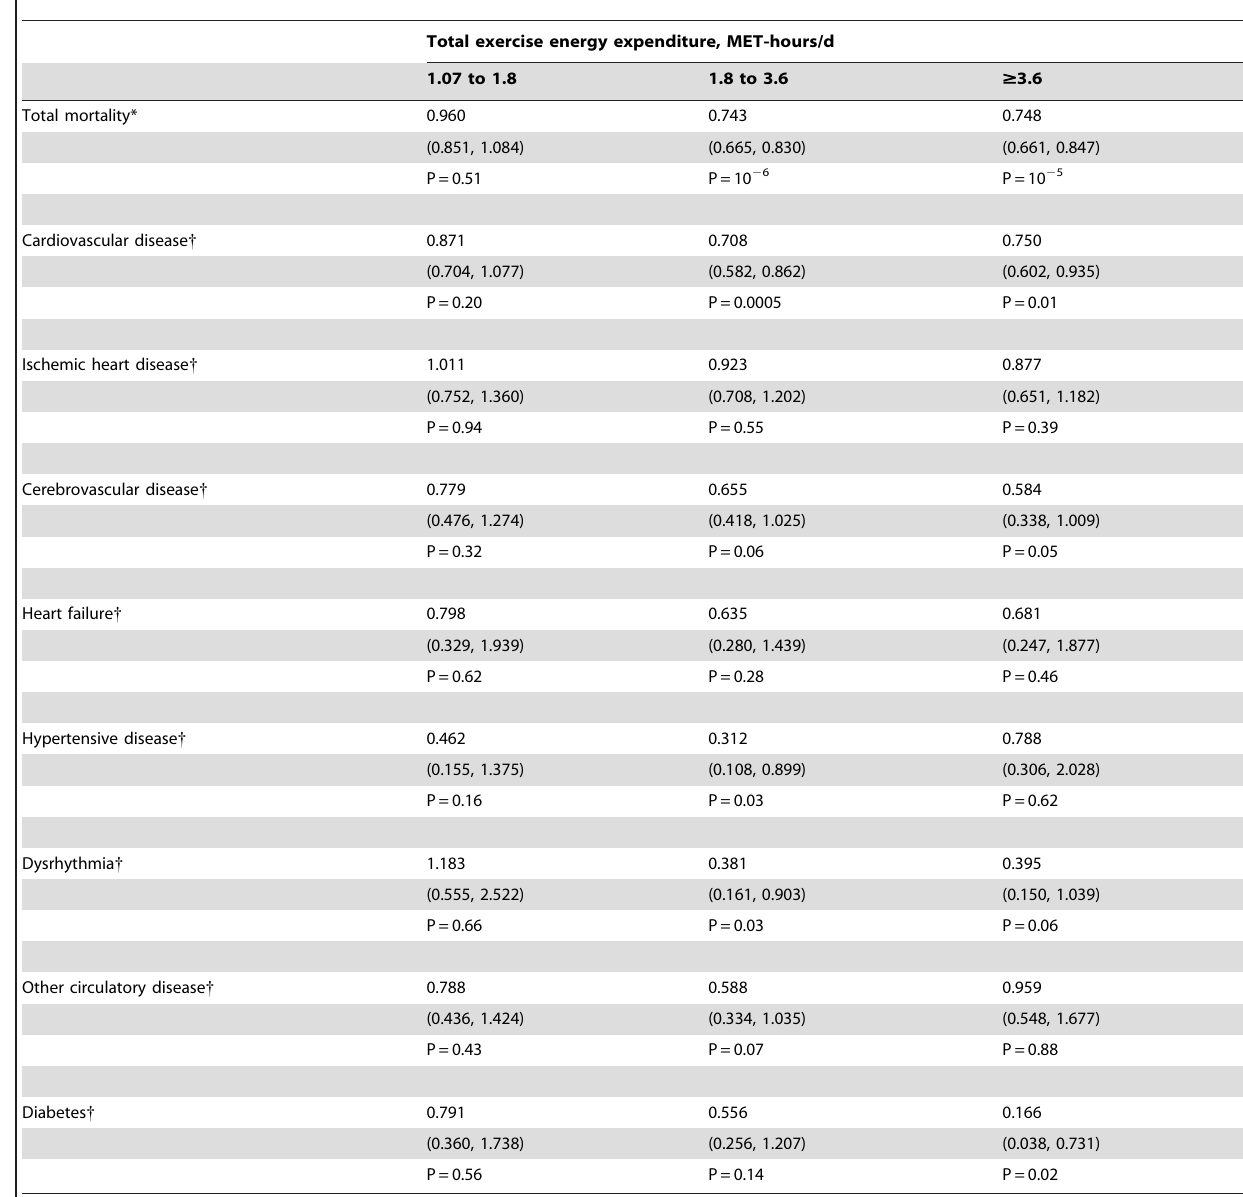
Table 4. Survival analyses of underlying cause of death vs. categories of physical activity adjusted for medication use and BMI baseline